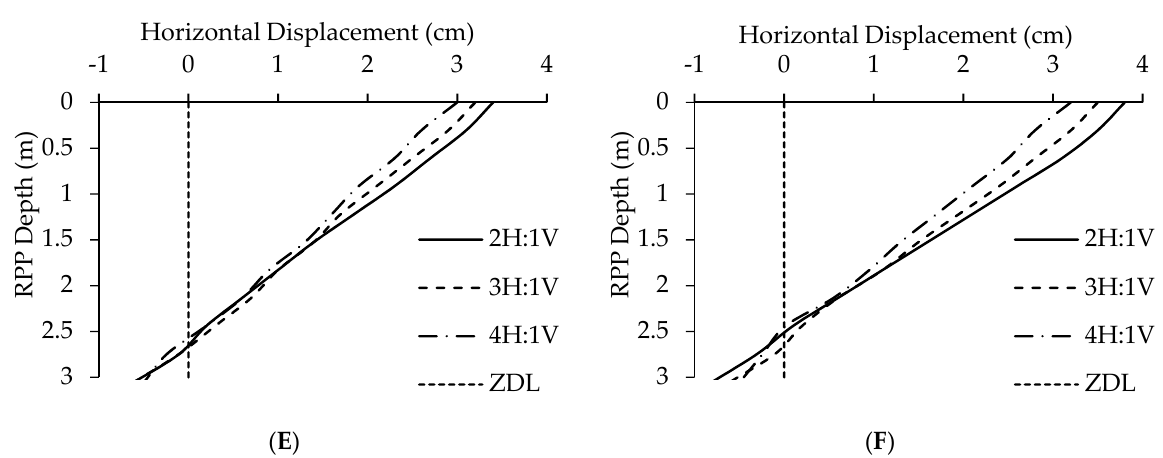
Figure 6. Horizontal displacement profile of RPPs at the crest of the highway slopes: ( A ) configuration A, ( B ) configuration B, ( C ) configuration C, ( D ) configuration D, ( E ) configuration E, and ( F ) configuration F (Zero Displacement Line (ZDL)).